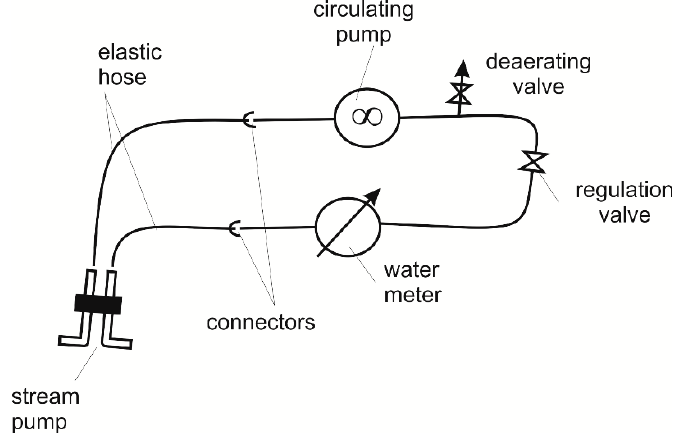
Figure 3. Sketch of a drive unit.